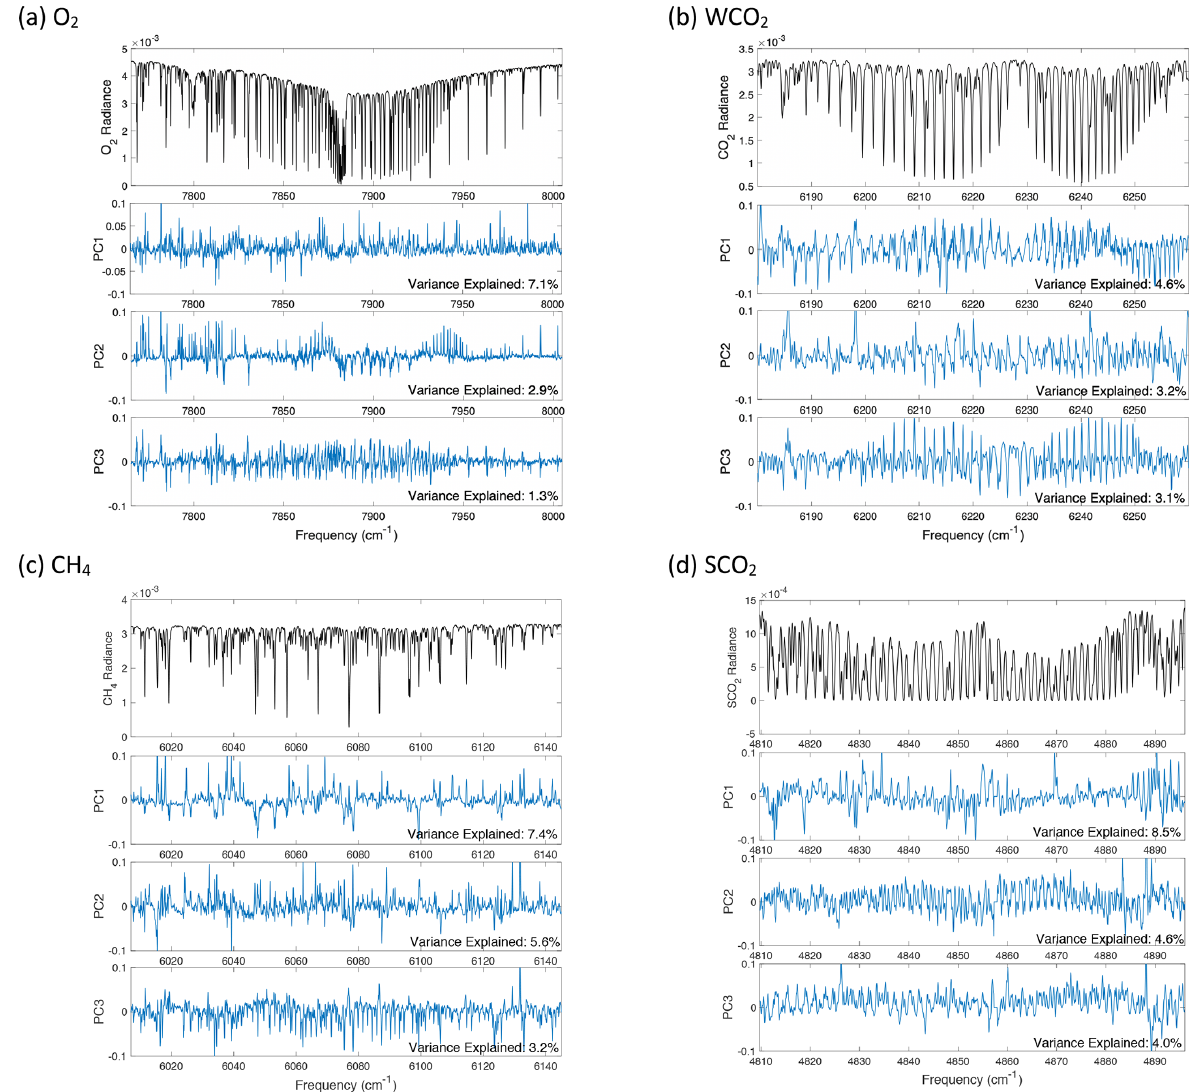
Figure A6. Mean radiance spectrum and the three leading PCs ranked by the variance explained by these PCs, obtained by applying PCA on the fitting residuals, for the (a) O 2 , (b) WCO 2 , (c) CH 4 , and (d) SCO 2 bands. The variance explained by each PC is also indicated.